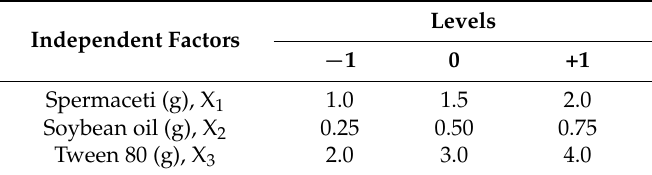
Table 3. The experimental variables and their